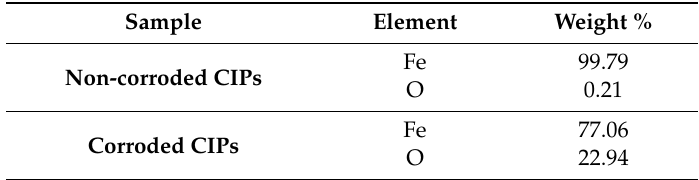
Table 1. Oxygen content of non-corroded and corroded CIPs by EDX.